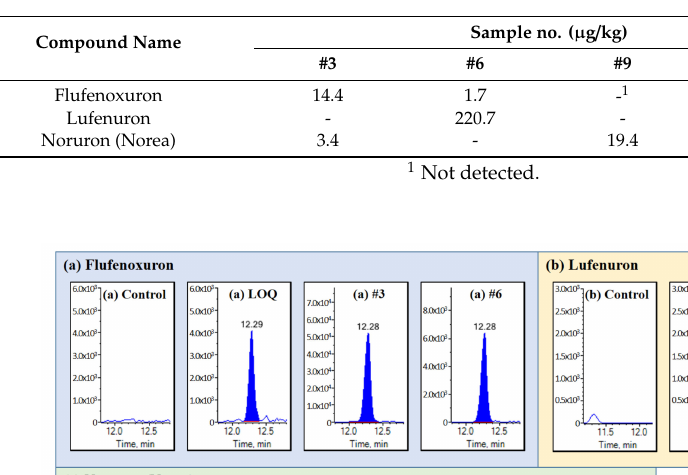
Table 5. Quantitative application results in mealworm samples obtained from commercial mealworm farms and pesticide maximum residue levels (MRLs) in terrestrial invertebrate animals including insects.